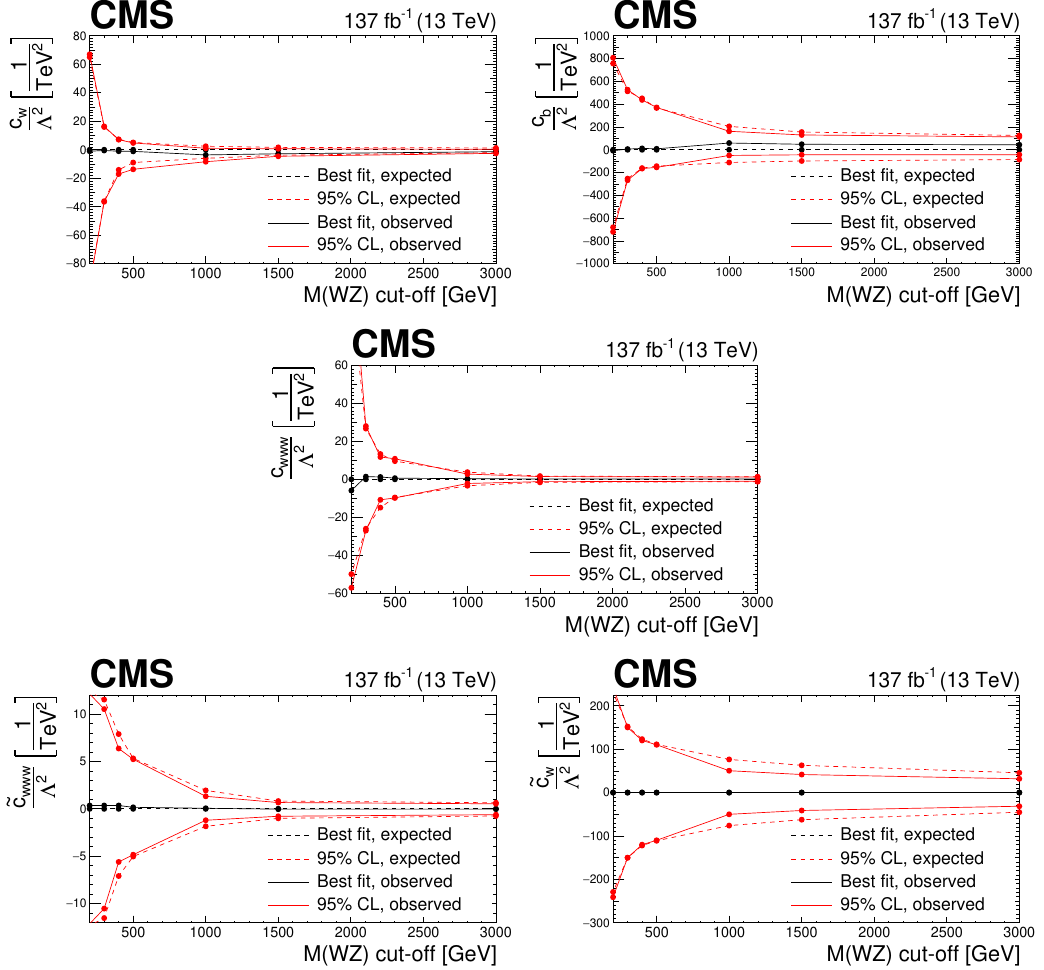
Figure 21 . Observed and expected evolution of the confidence intervals in the EFT anomalous coupling parameters in terms of the cutoff scale given by different restrictions in the M (WZ) vari- able. For each point and parameter, the confidence intervals are computed imposing the additional restriction of no anomalous coupling contribution on top of the SM prediction over the given value of M (WZ) . Because of the statistical limitations in our simulation the last point is equivalent to no cut-off requirement being